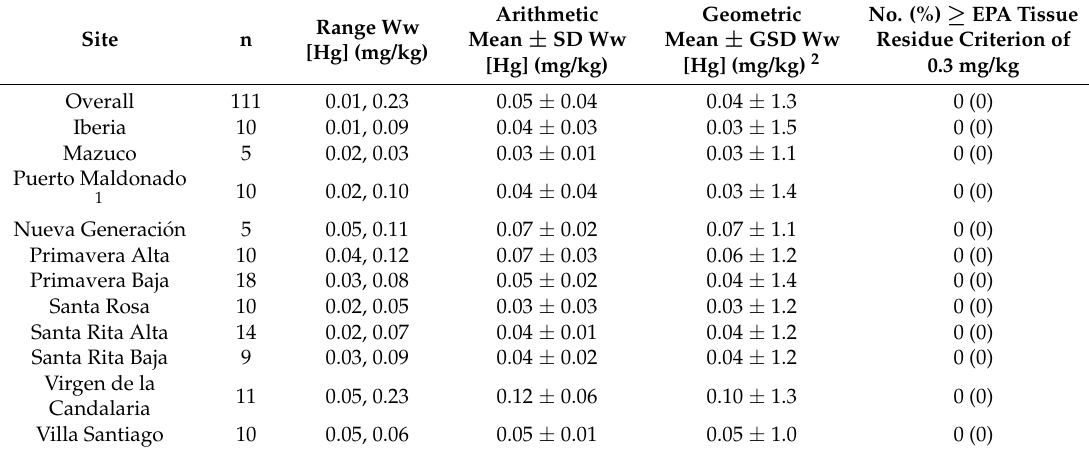
Table 6. Descriptive statistics for measured mercury concentration in paco fish tissue samples at 24 sites in the Madre de Dios river basin of Southeastern